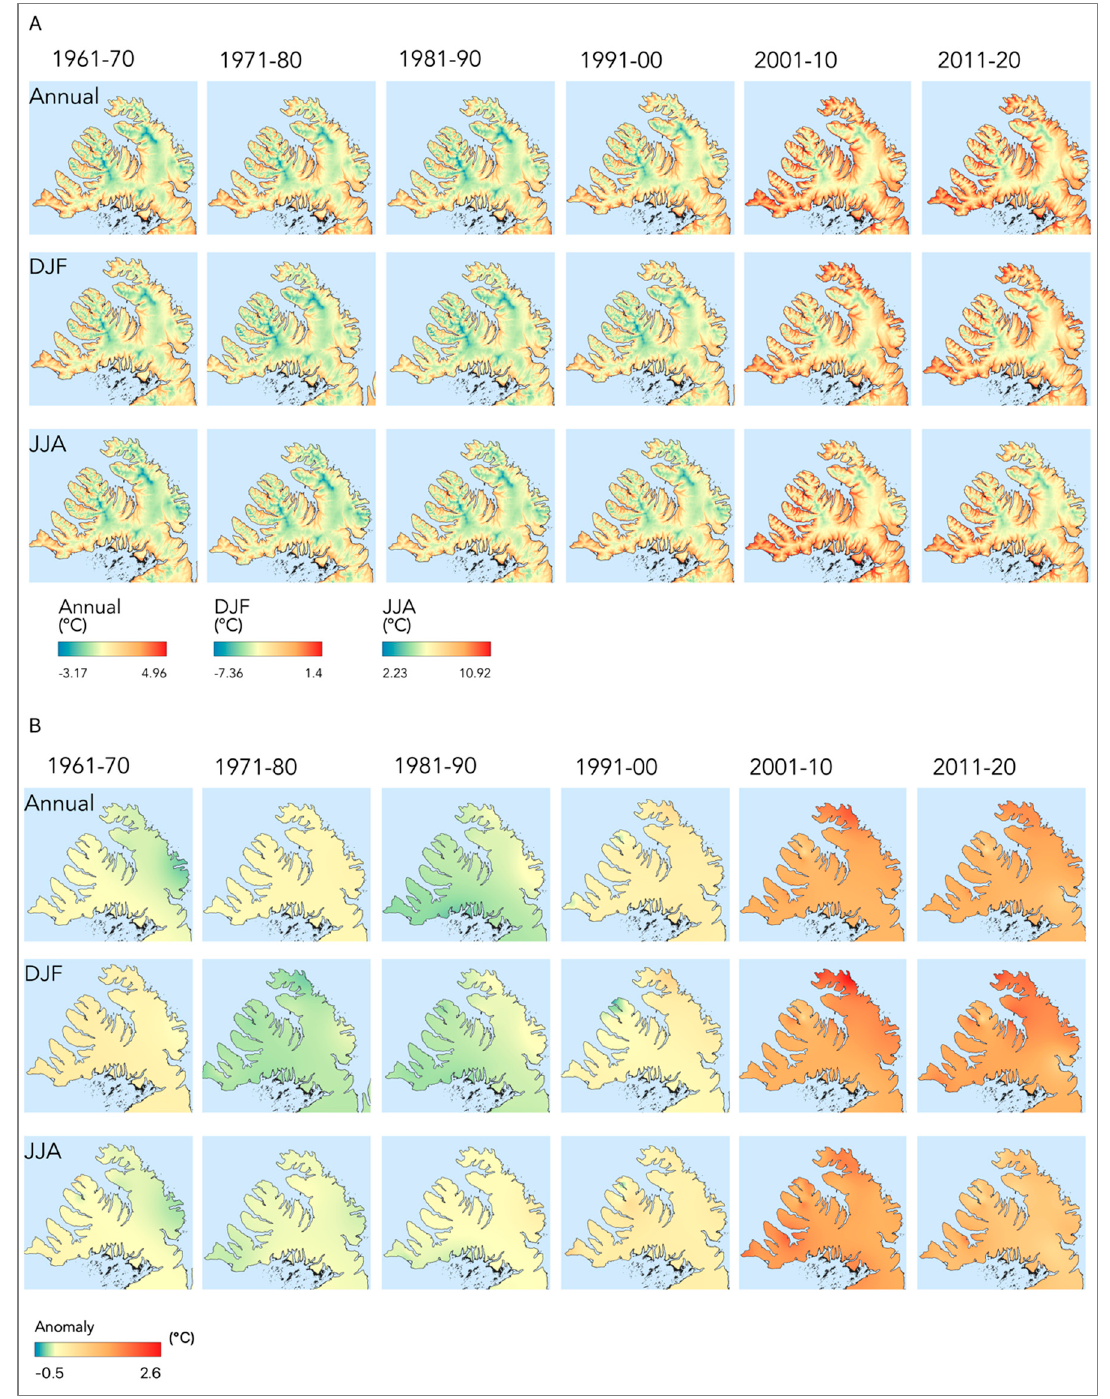
Figure 9. Spatial distribution of absolute temperature changes ( A ) and temperature changes relative to the 1961–1990 mean ( B ) for each decade of 1961–2020. DJF: December, January, February. JJA: